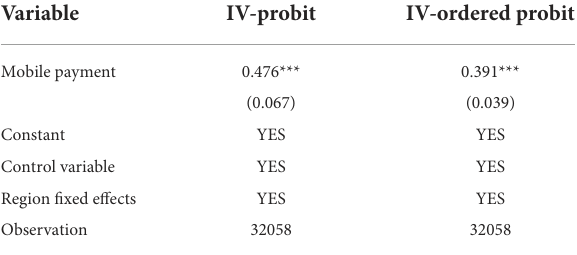
TABLE 6 Results for robustness check.